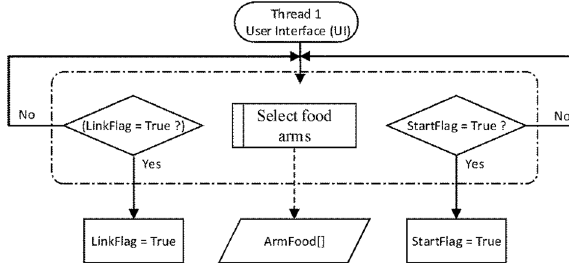
Figure 3. Flow of the UI thread.